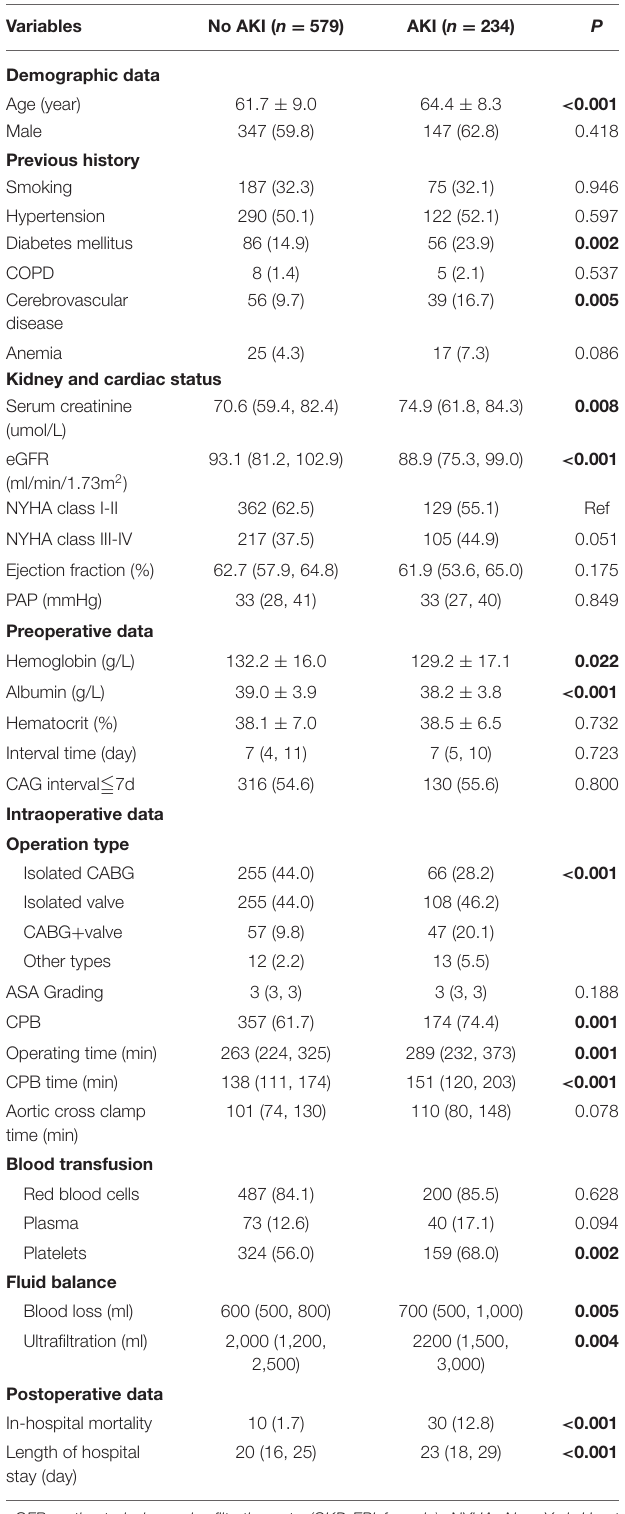
TABLE 2 | Preoperative, operative, and postoperative univariate analysis of AKI. Variables